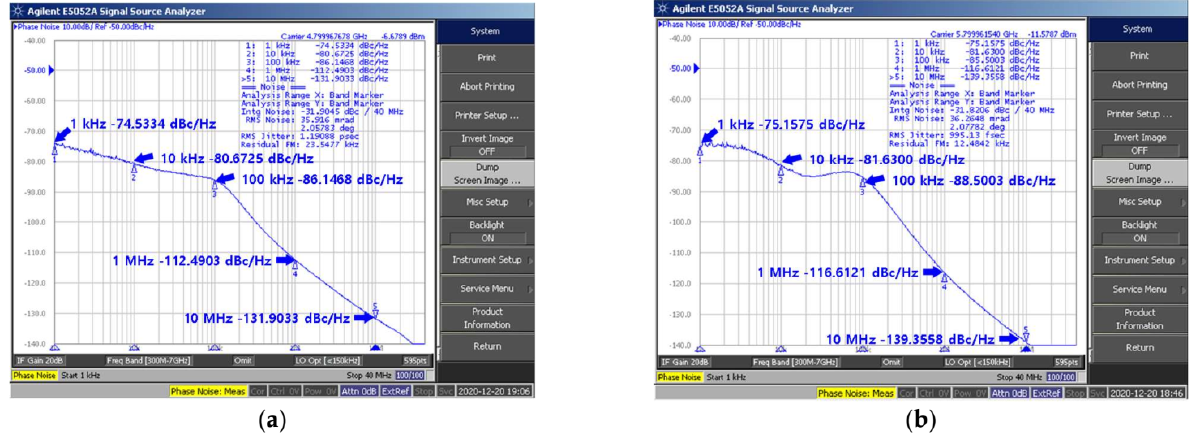
Figure 12. Measured phase noise of the proposed PLL at ( a ) 4.8 GHz, and ( b ) 5.8